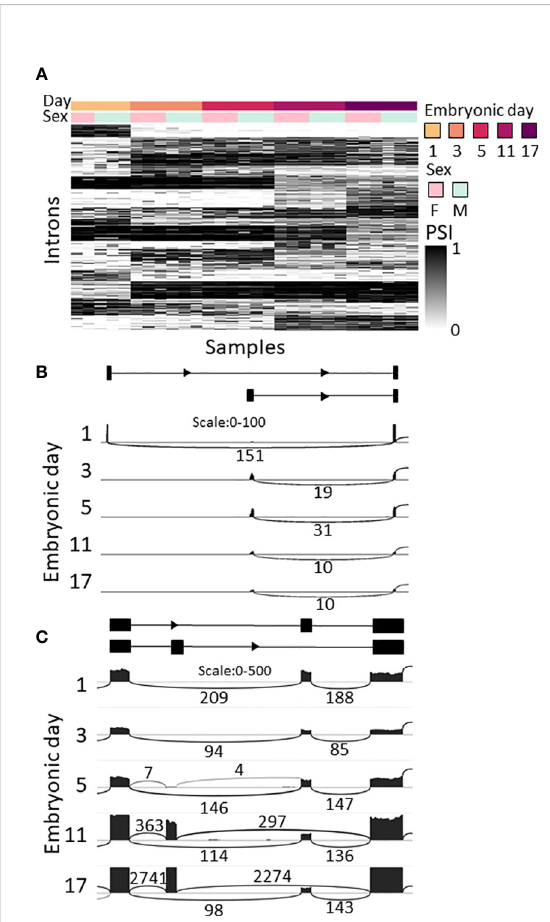
FIGURE 4 Splicing changes during M. rosenbergii embryonic development. (A) Splicing ratio, the percent spliced in (PSI), heatmap of the introns that were differentially spliced between embryonic days. Only the 500 introns with the highest D are shown. Differentially spliced introns with similar patterns were clustered together. Heatmap colors represent PSI values; see color bar on the right. (B) Sashimi plot of alternative fi rst exons in gene g31925, whose ratio changed between day 1 and later embryonic days sampled. Top, diagram of gene structure. Arcs represent splicing junctions, and the numbers on the arcs are the number of junction spanning reads that fall on the junctions. In all subplots, Female_B is displayed as a representative. (C) Sashimi plot of mutually exclusive exons in g42168. In samples from 1- to 5- day-old embryos only one transcript is expressed, and in samples of 11- to 17-day-old embryos both transcripts are expressed. Top, diagram of gene structure. Gene structure was inferred from the RNA-seq reads, as this gene is not in the current transcriptome. In all subplots, Female_B is displayed as a